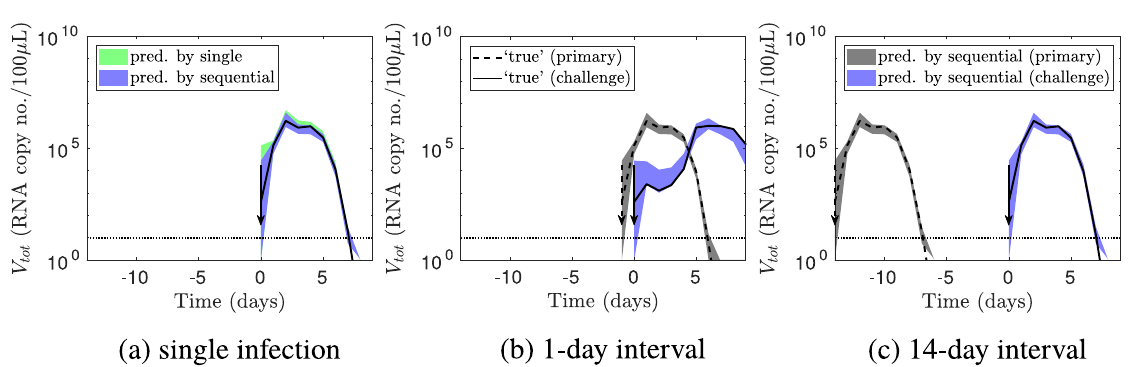
Fig 2. Verification that the fitting procedure recovered the viral load. (a) For a single infection, the blue and green areas are the 95% credible intervals for the viral load (in the absence of noise), as predicted by the models fitted to the sequential infection and single infection data respectively. (b—c) For sequential infections with the labelled inter-exposure interval, the grey and blue areas show the 95% credible intervals for the primary and challenge viral load respectively, predicted by the model fitted to sequential infection data. The other elements of the figure are identical to Fig 1: the dashed and dotted lines show the simulated ‘true’ viral load for a primary and challenge infection respectively; the arrows show the times of the primary and challenge exposures; and the horizontal line indicates the observation threshold. Fig 2b and 2c confirm that fitting to sequential infection data accurately recovered the viral load for different inter-exposure intervals. The grey and blue areas show the 95% credible intervals for the primary and challenge viral load respectively.